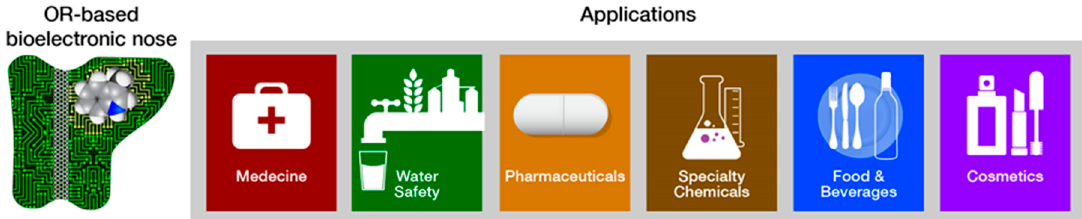
Figure 1. Odorant receptor (OR)-based biosensors and their applications. ORs have great potential as biorecognition elements in many sensor configurations. In particular, the integration of ORs and electronic transducers combines the selectivity of the OR with the intrinsic sensitivity of nanoscale solid-state platforms, enabling direct transduction of ligand binding into electronic current. Bioelectronic noses may be applied as accurate, affordable and easy to use diagnostic devices in many fields ranging from agro-food sectors to the clinical arena.